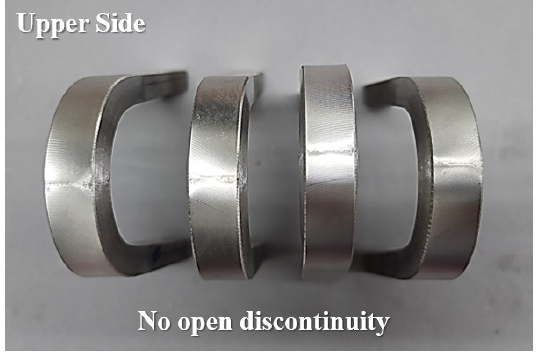
Figure 7. Appearance of the specimen after the bend test.